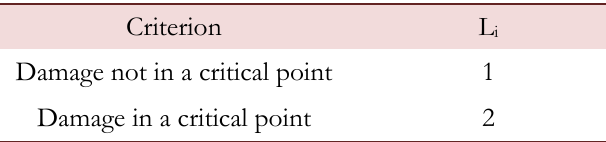
Table 1: L i parameter values representing the damages location